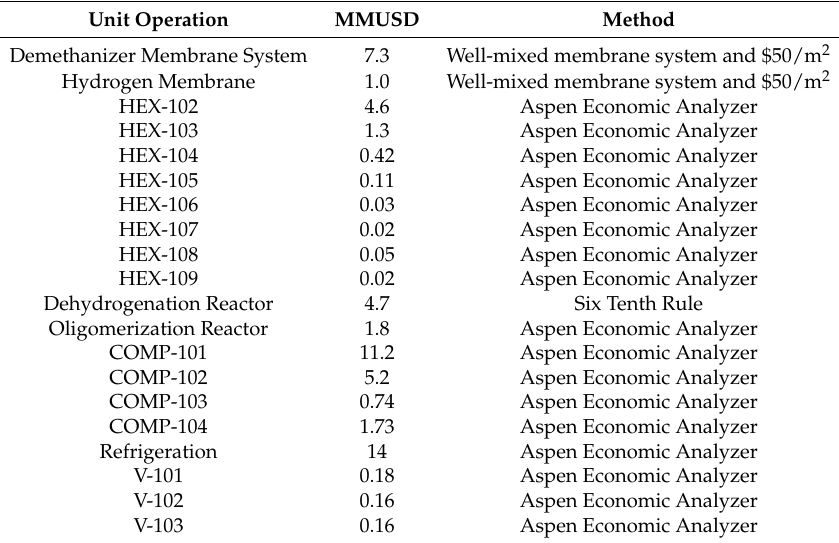
Table A2. Equipment cost for unit operations in Process